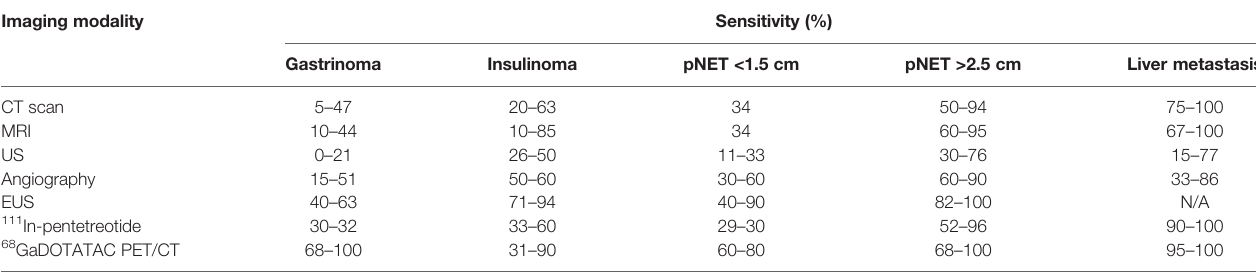
TABLE 3 | The sensitivity of different imaging modalities for pNETs and their metastases in the liver. Imaging modality